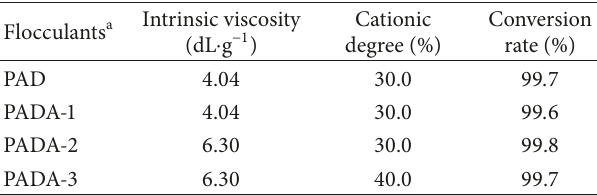
Table 1: The details of flocculants used in this study.